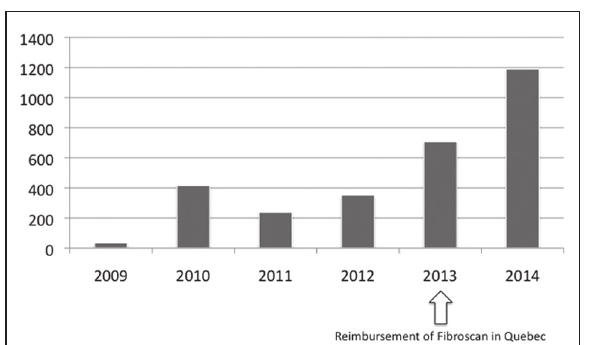
Figure 1) Number of Fibroscan (Echosens, France) examinations per- formed at McGill University Health Centre (Montreal, Quebec) from 2009 to 2014. Arrow indicates the year when reimbursement for the procedure was